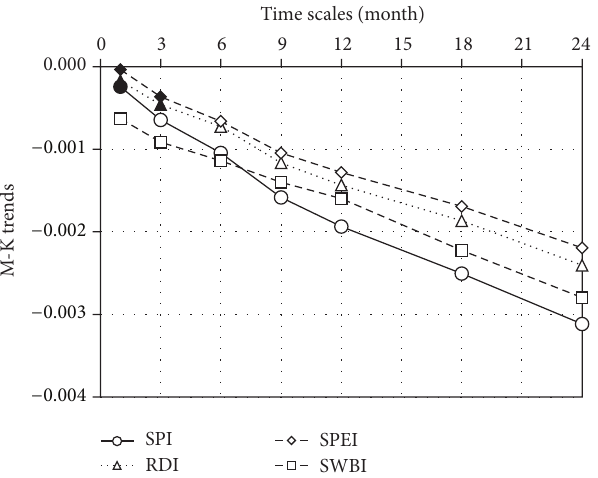
Figure 9: Drought episodes of different drought classifications identified by drought indices at time scale of 12 months.